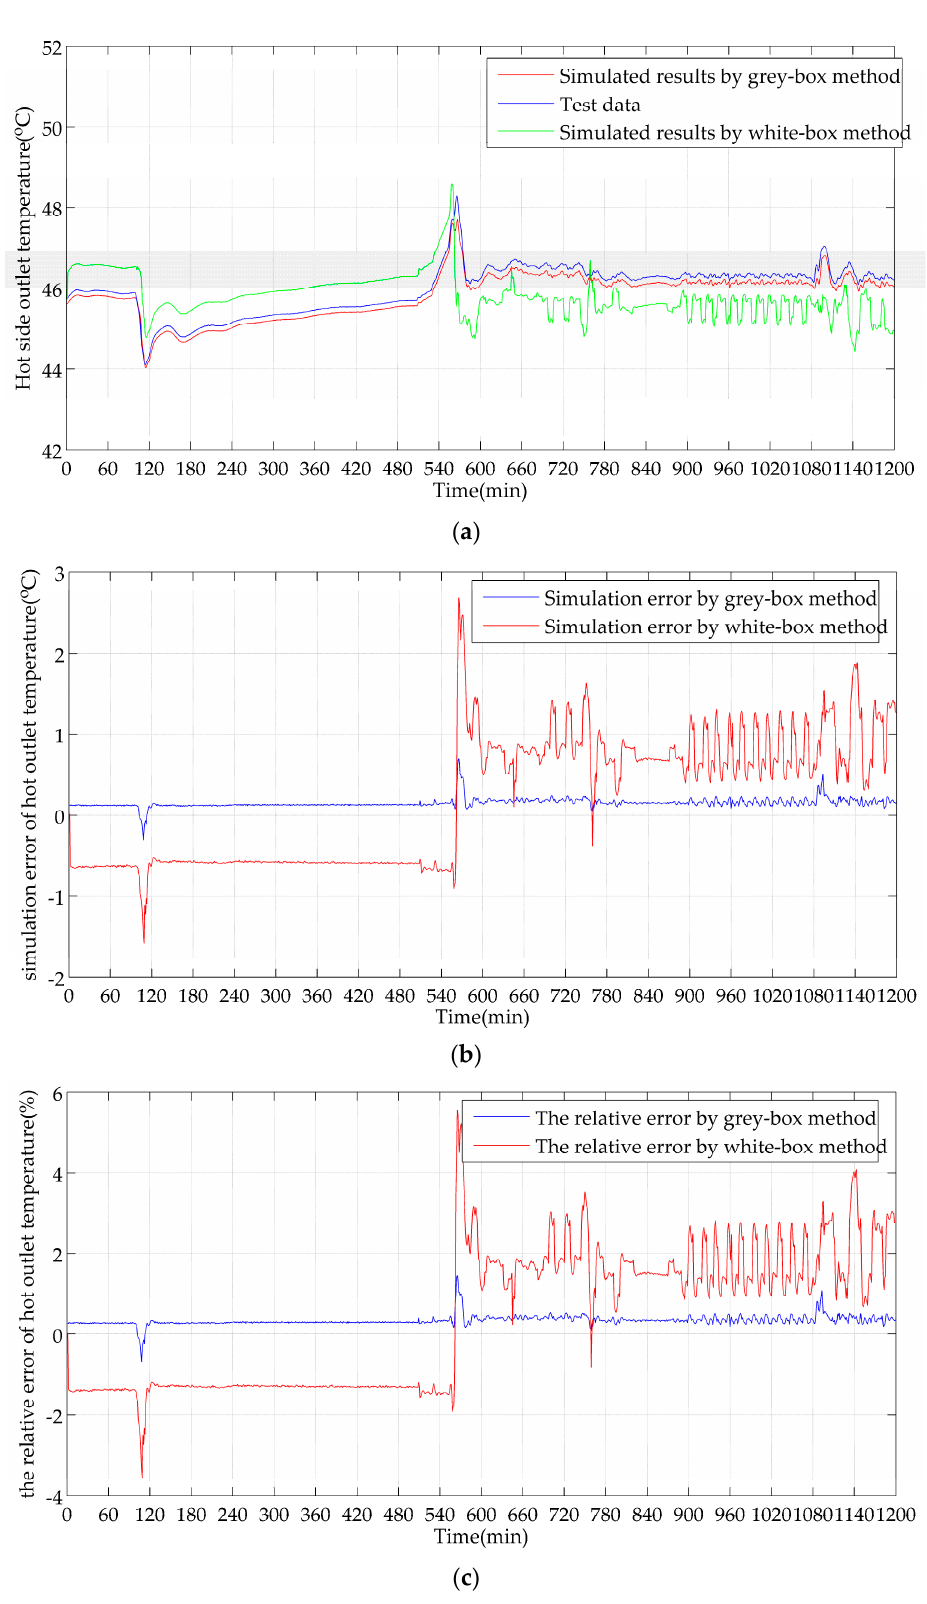
Figure 8. ( a ) Comparison of simulated T h ,2 with test data; ( b ) Simulation error of T h ,2 by white-box and grey-box method; ( c ) The relative error of T h ,2 by white-box and grey-box